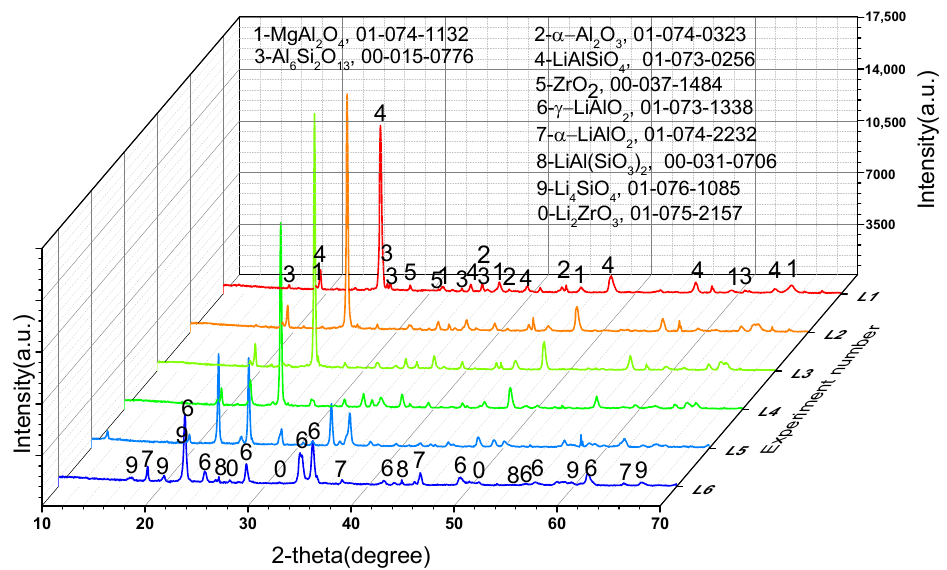
Figure 8. XRD spectra of the corrosion reaction of saggar powder with different contents of lithium carbonate.